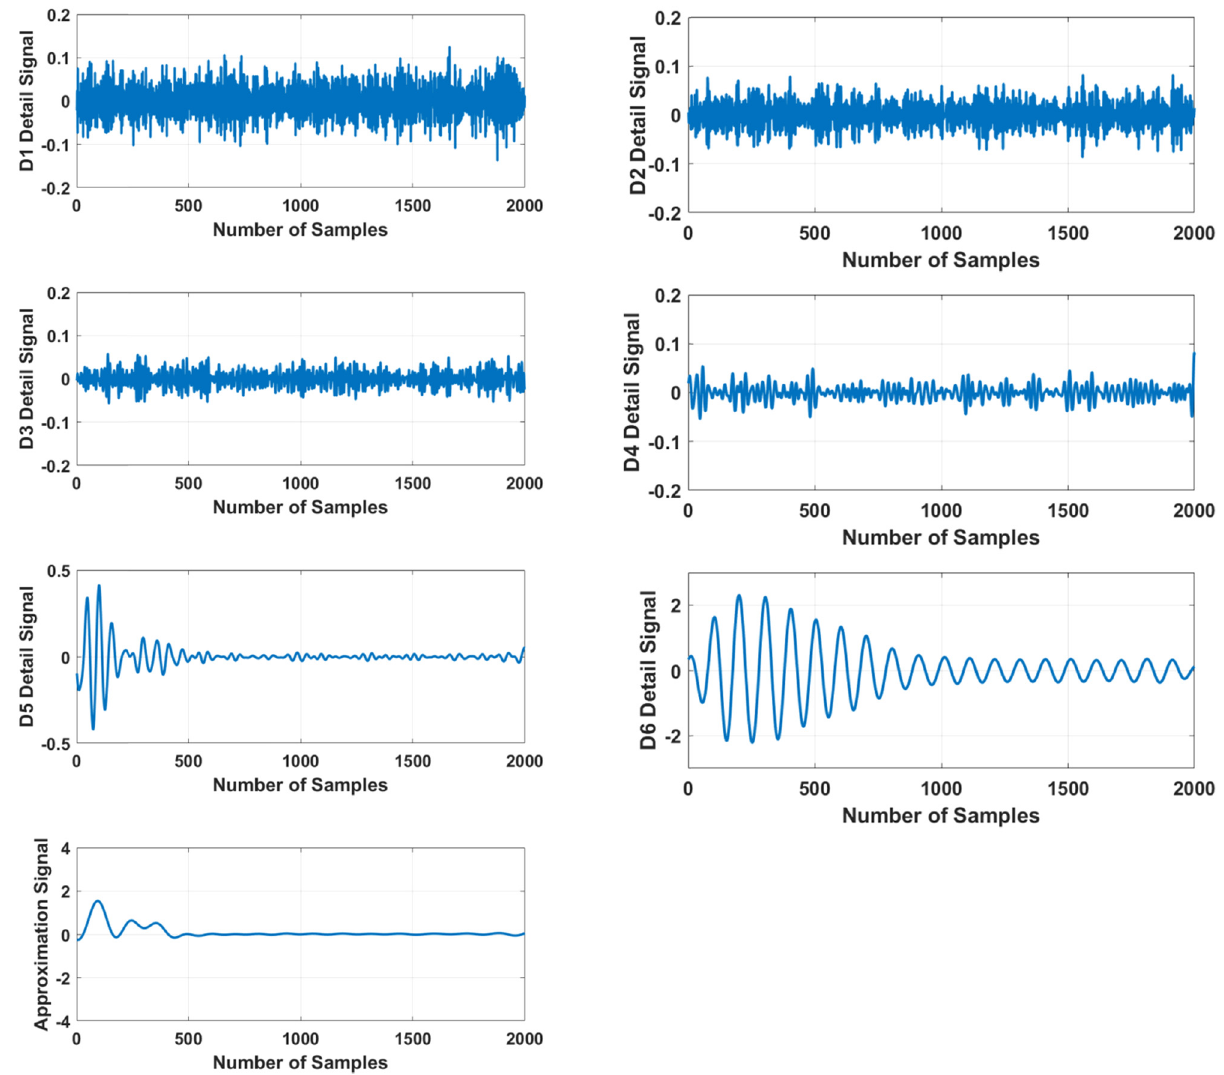
Figure 8: Reconstruction of the signal from the detail coe ffi cients for transient